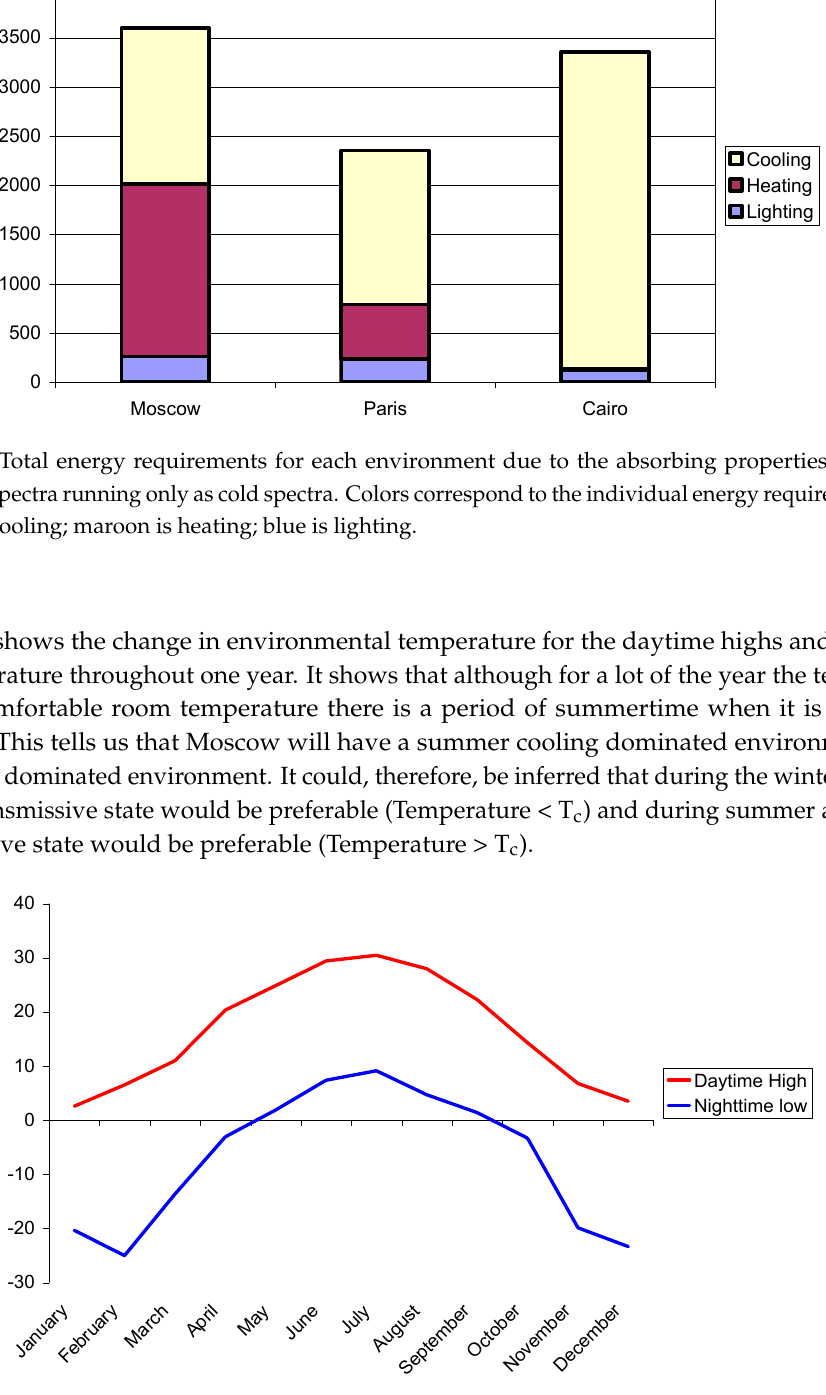
Figure 2. The daytime highs and nighttime lows of the Moscow environment throughout one year.